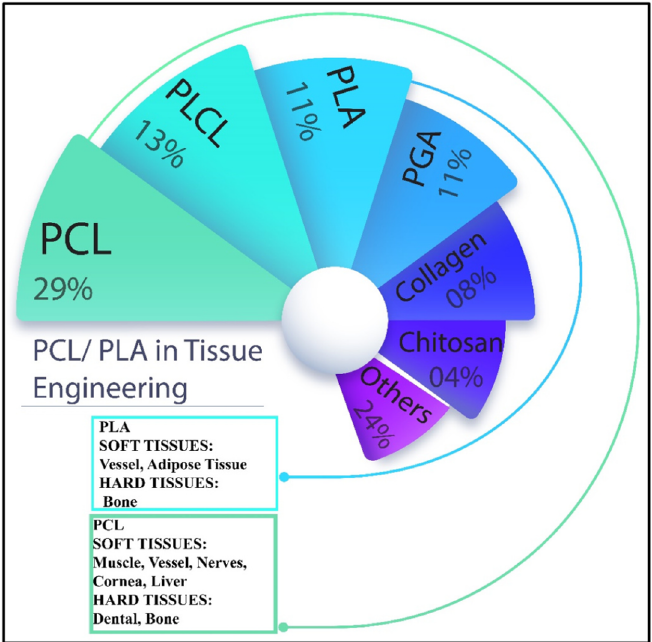
Figure 6. List of biopolymers used in fabrication of scaffolds for tissue regeneration [47]. Nanocomposites exhibit higher mechanical strength, greater heat resistance, and even self-healing behavior compared to pure polymers and conventional composites